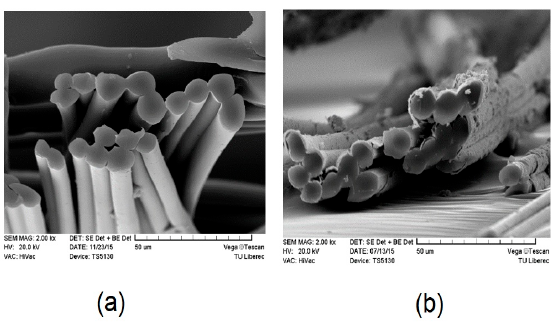
Figure 5. A cross sectional view of Cu/Ni-coated Milife fabric ( a ) sample N0; ( b ) sample N8.